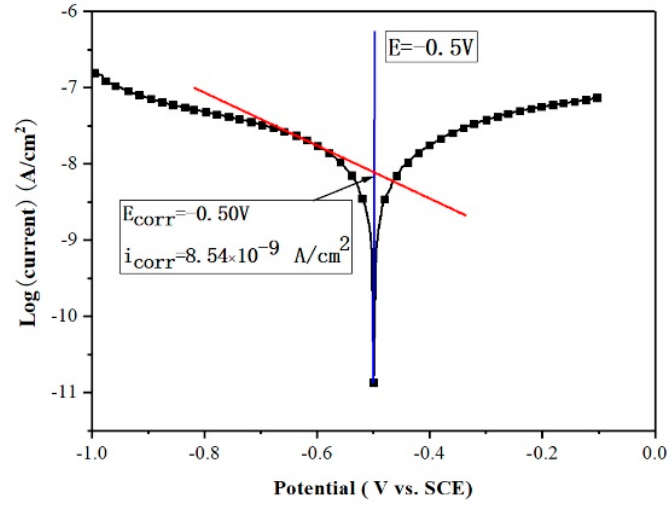
Figure 1. Polarization curves of an Al − alloy coated with different PE-coatings.